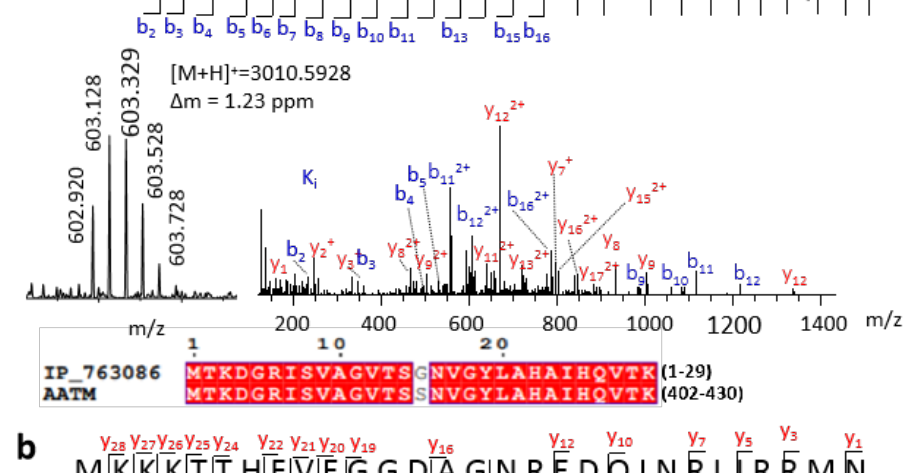
SEP fragments were detected with mass shift when using TopPIC searching (Figure S4), which means potential unknown modifications or partial amino acid mutation.